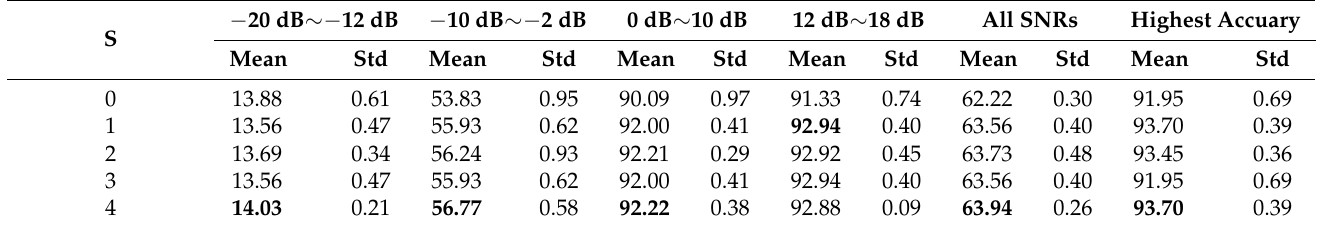
Table 6. Accuracy of LENet-S with varying augmentation transformation parameters ( S ). The top1 accuracy for each SNR interval is highlighted.